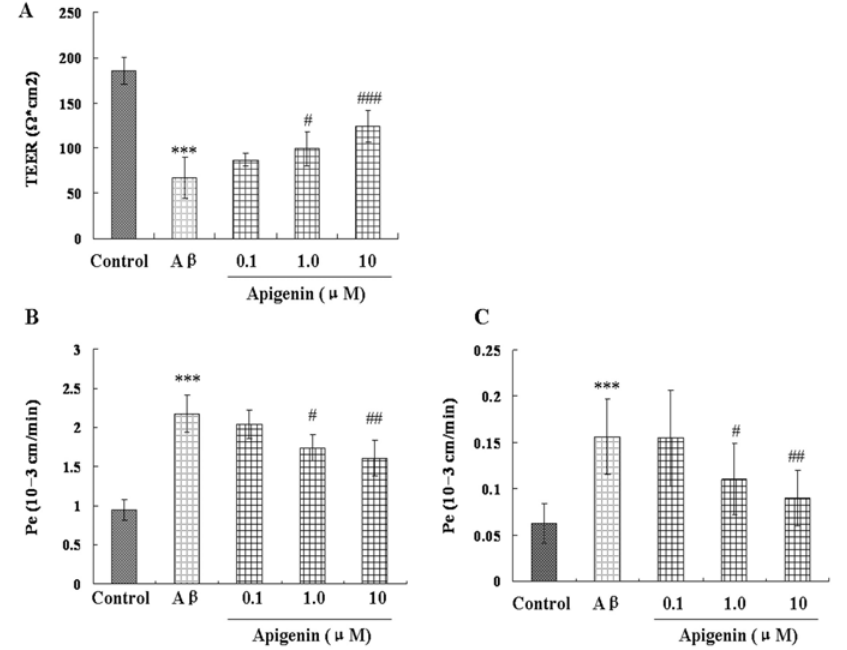
Figure 3. Effects of apigenin on transendothelial electrical resistance (TEER) (A); and transendotheial permeability for sodium fluorescein (B); and FITC labeled albumin (C) in -induced rat CMEC monolayers against A β 25–35